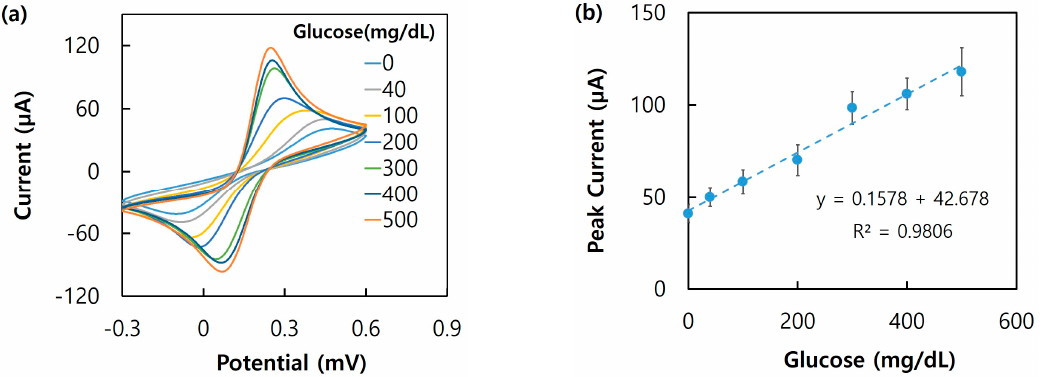
Figure 3. Electrochemical detection of glucose using DA-modified electrode. ( a ) CVs and ( b ) peak currents obtained after applying 50 µL of 0.1 × PBS (pH 7.4) containing 10 mM Fe(CN) 63 − /4 − , 0.1